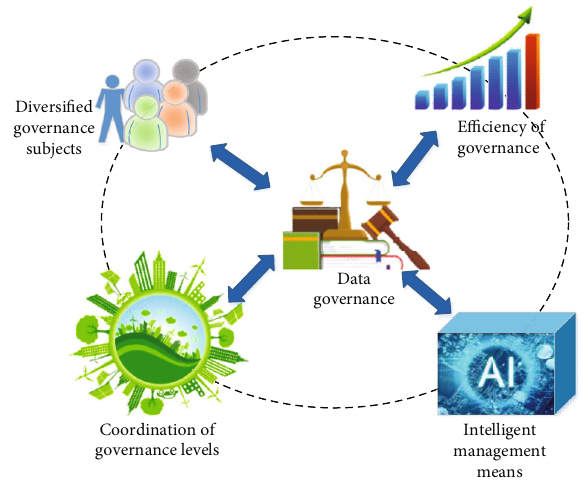
Figure 1: Schematic diagram of relative poverty data visualization governance